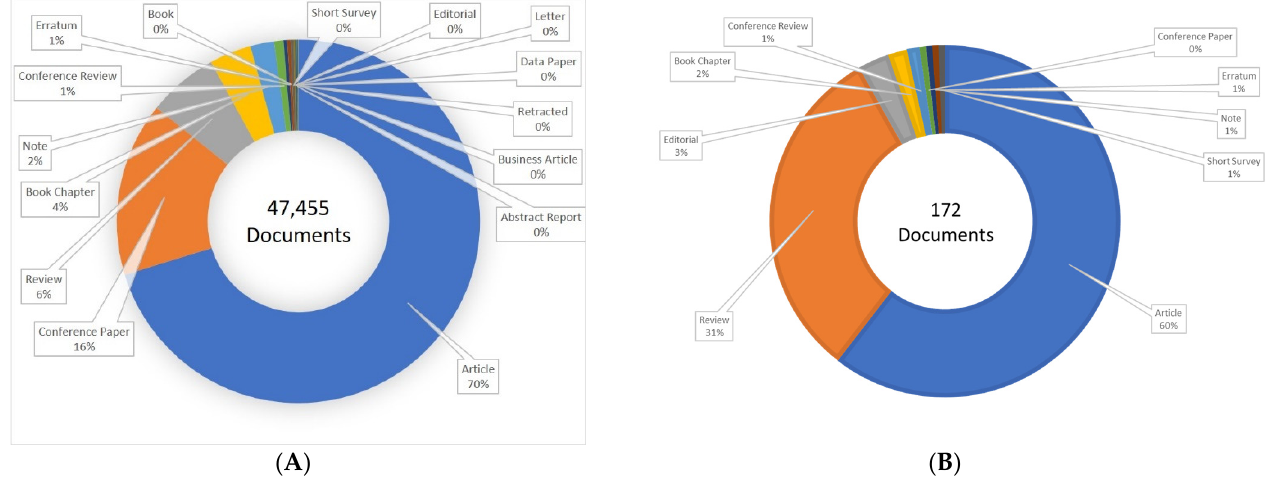
Figure 5. Different types of documents published with keywords ( A ) ‘biodiesel’ and ( B ) ‘biodiesel and bioengineering’.